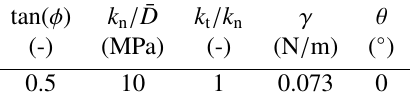
Table 1. Discrete element method model